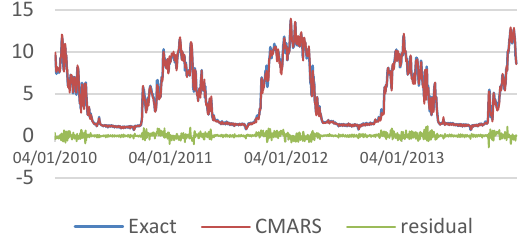
Figure 4. Exact values and CMARS approximation of natural gas consumption for one-day ahead prediction based on test data